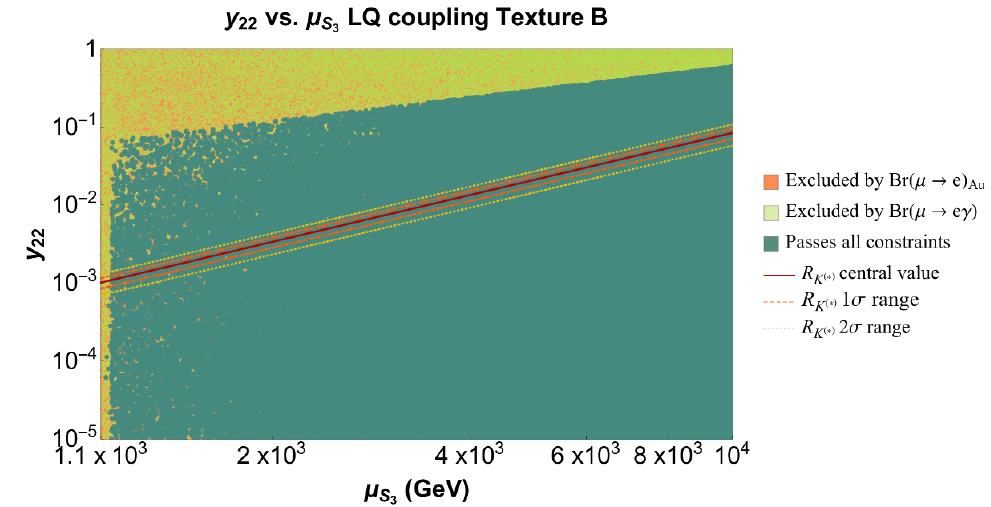
Figure 16 . Indicative plot of the allowed parameter space in the y 22 vs. (cid:22) S plane, for leptoquark 3 coupling matrix Texture B. The red line indicates the central value needed to explain the R K ( (cid:3) ) anomalies with the dotted orange (yellow) lines indicating the 1(2) (cid:27) bounds. The orange region of the parameter space is constrained by Br( (cid:22) ! e ) Au , the teal region is allowed; speci(cid:12)cally it passes all constraints discussed in section 3 as well as perturbativity constraints on the diquark coupling constants z LL . The light green region, which in this plot has been superimposed on the 1 ij orange, shows parameter space that is excluded by Br( (cid:22) ! e(cid:13) ).